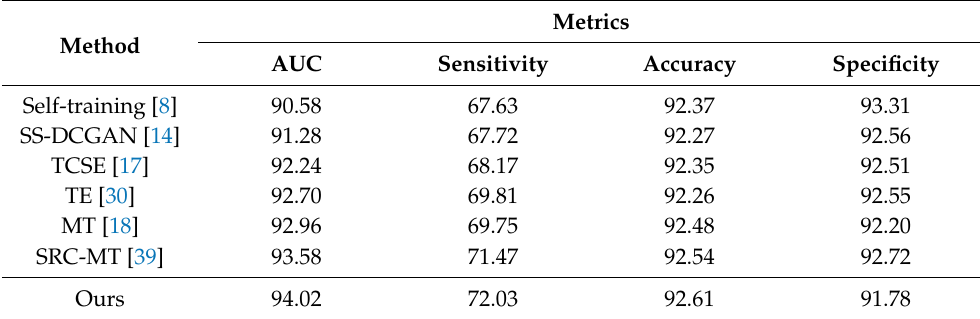
Table 1. Performance comparison between the ISIC 2018 dataset and previous examples of semi- supervised